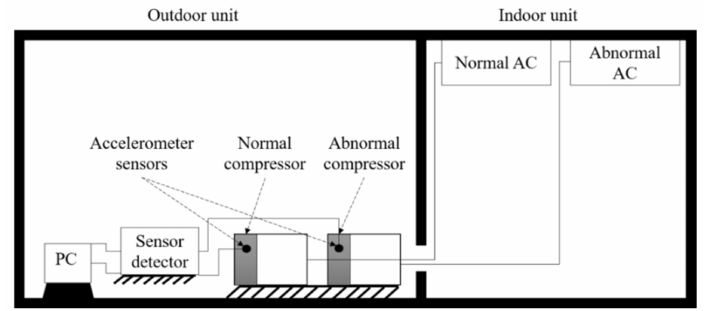
Figure 5. Schematic of the experiment setup in case 3 and case 4